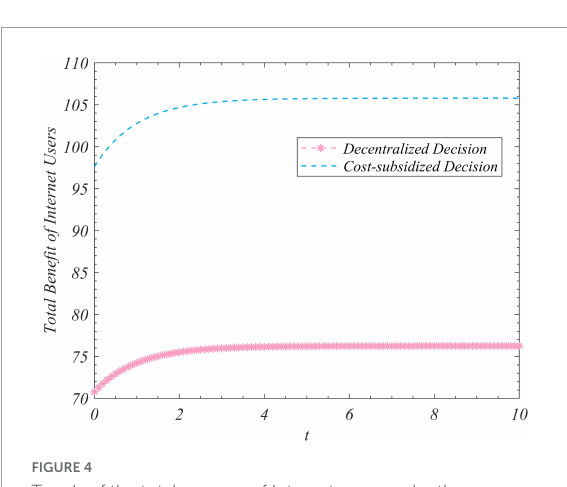
FIGURE4 Trends of the total revenue of Internet users under the decentralized and subsidized decision-making scenarios.